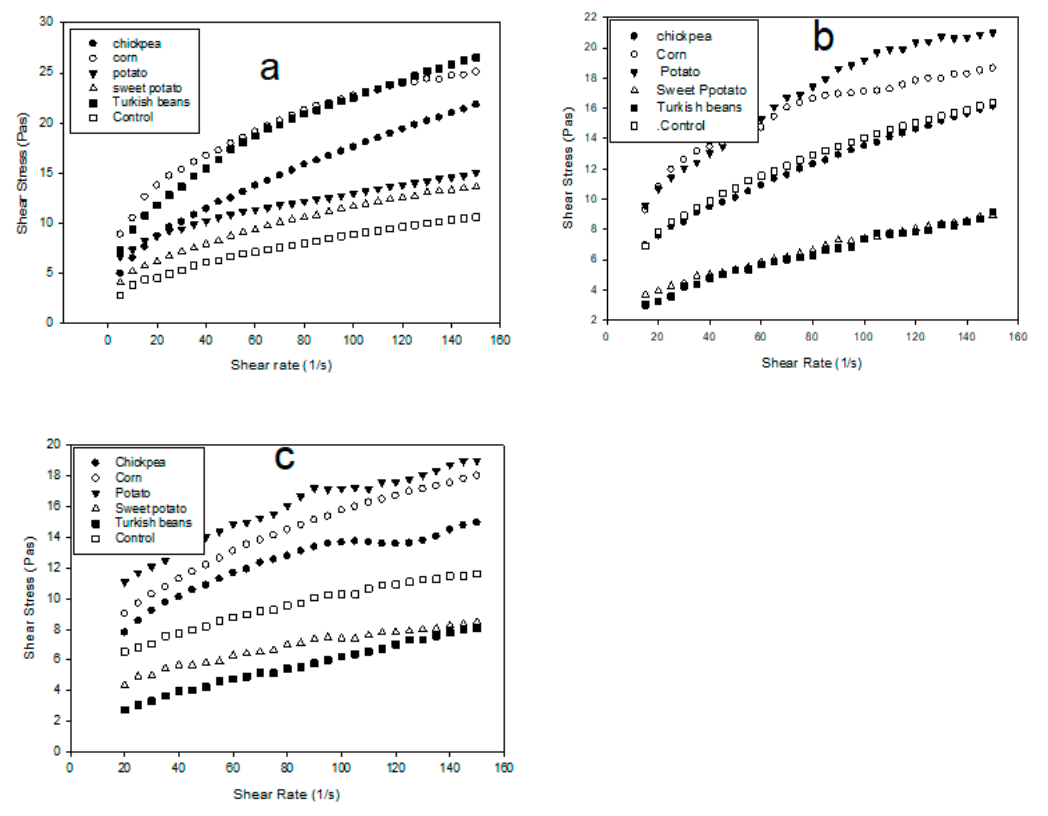
Figure 1. Shear rate shear stress relationship for fresh yoghurt fortified with deferent starches after ( a ) 0 storage days, ( b ) 7 storage days, and ( c ) 15 storage days .